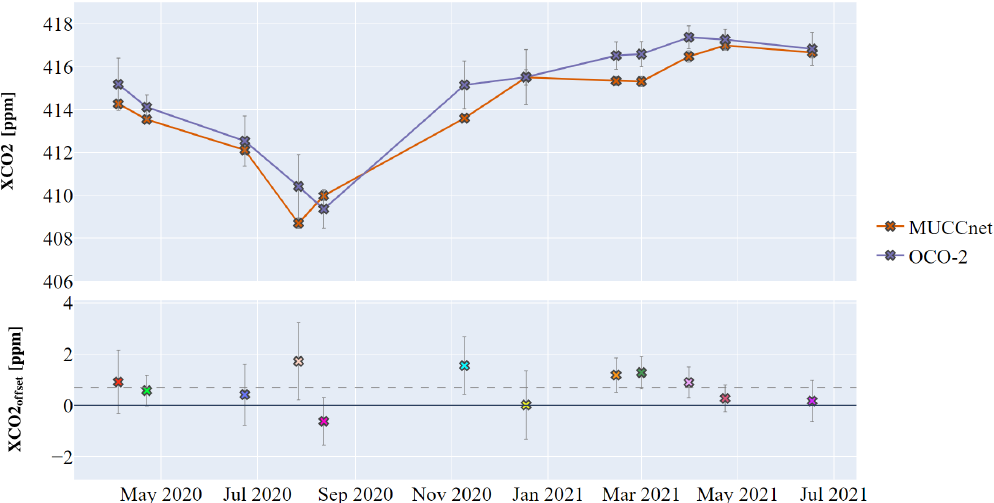
Figure 8. Both observing systems detect the seasonal X CO daily X CO differences of satellite data and MUCCnet observations. The spaceborne observations are biased high by 2